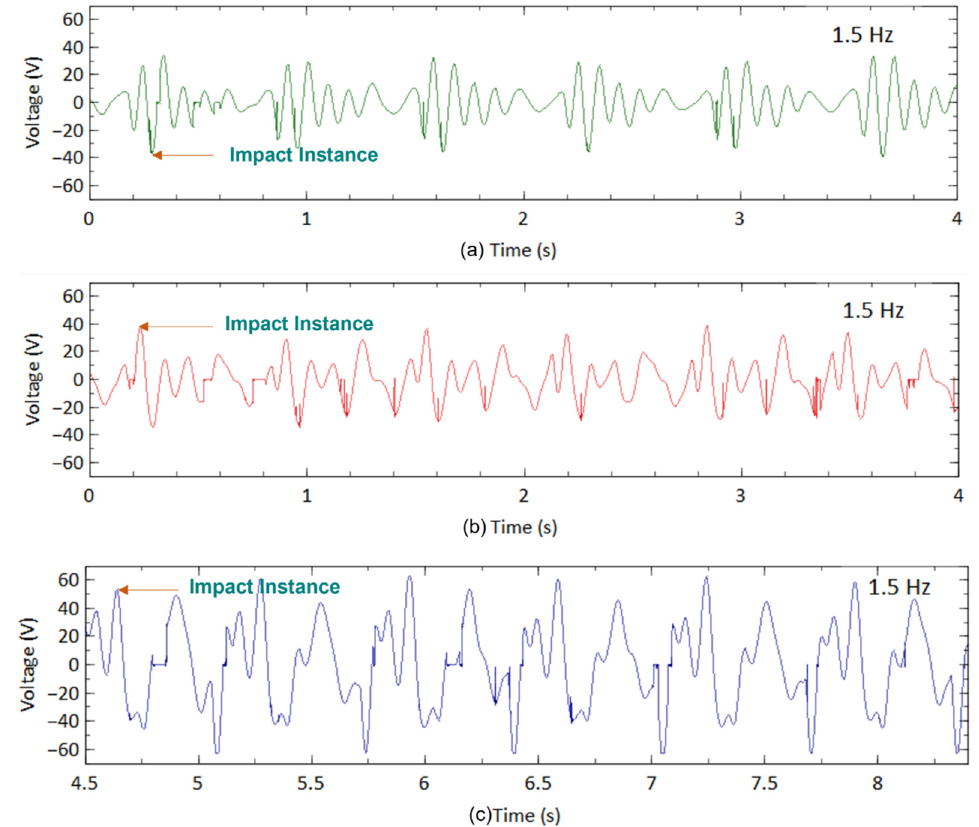
Figure 13. Voltage output of ( a ) CBH, ( b ) VBH, and ( c ) BBBH for human running motion (1.5 Hz).